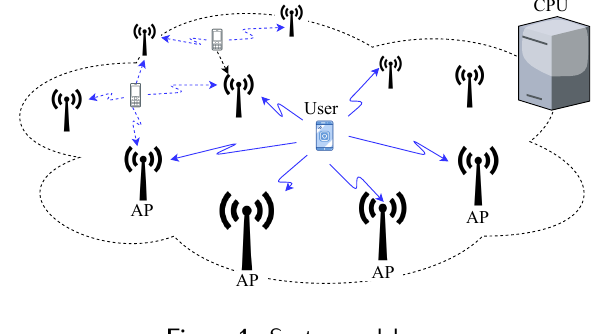
Figure 1. System